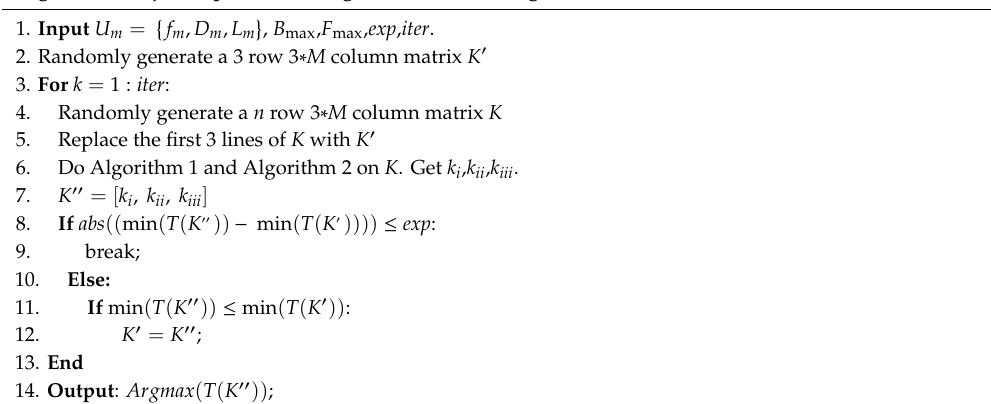
Algorithm 3 A joint optimization algorithm of o ffl oading and resource